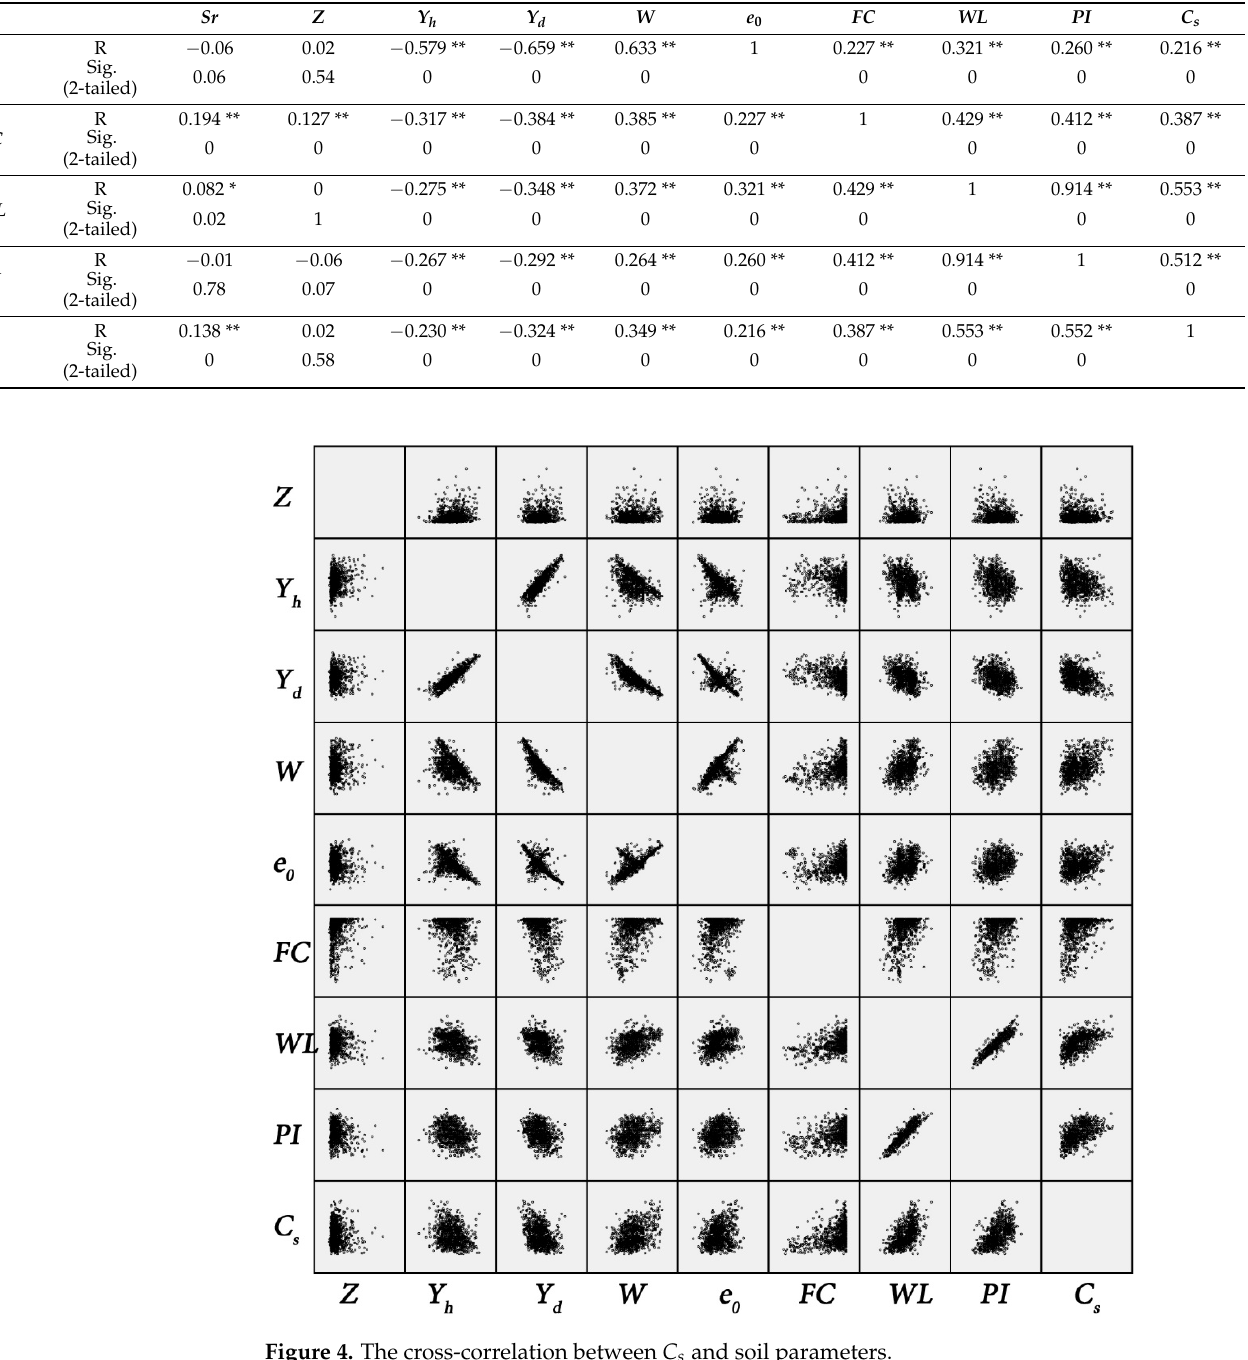
Figure 4. The cross-correlation between C s and soil parameters.